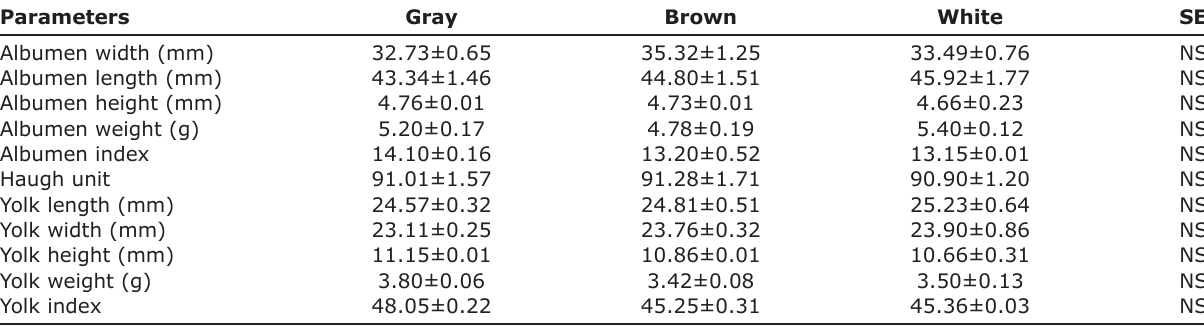
Table-4: Internal egg quality traits of three varieties of Japanese